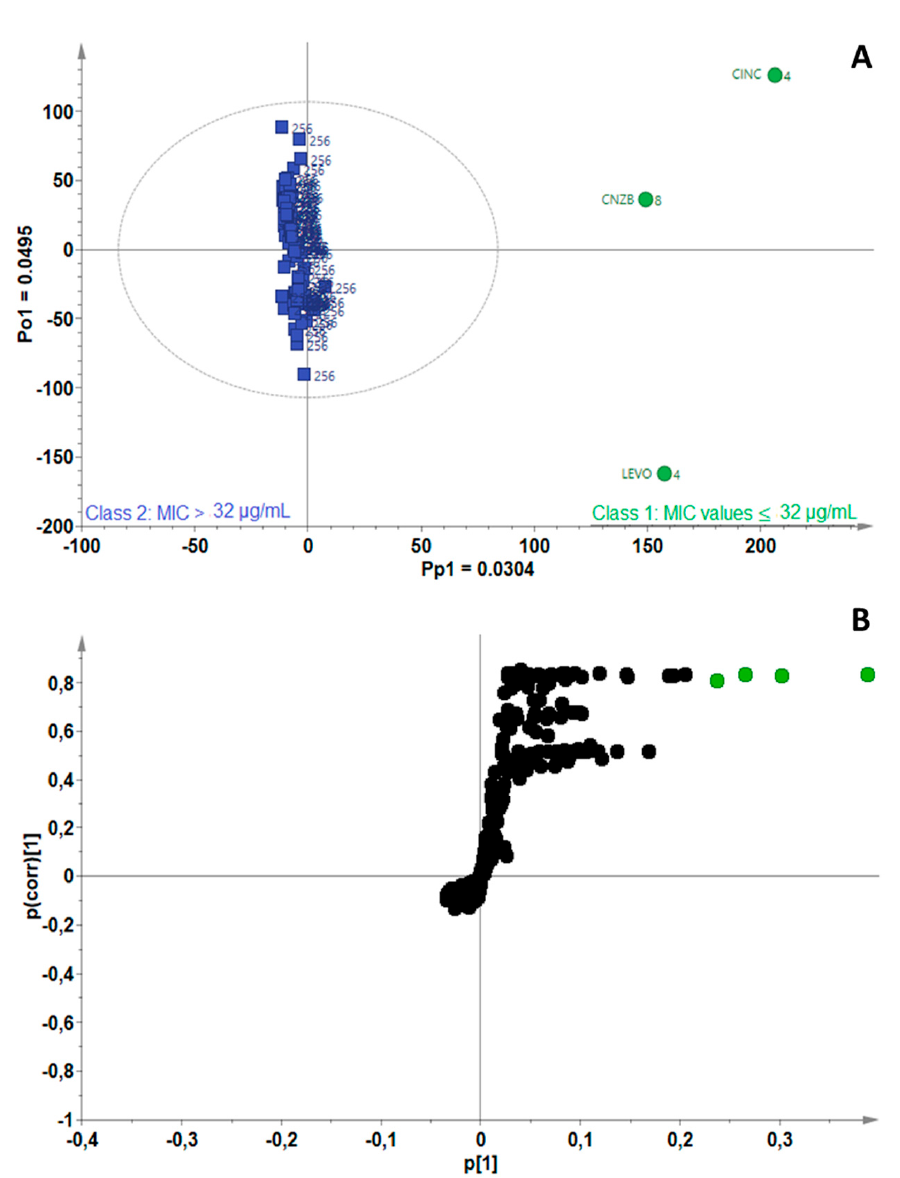
Figure 5. ( A ) OPLS-DA scores scatterplot for Mycobacterium tuberculosis showing separation of active (green) and non-active (blue) essential oils, ( B ) S-plot of the variables, indicating the putative biomarkers (green) associated with essential oils active against M. tuberculosis .